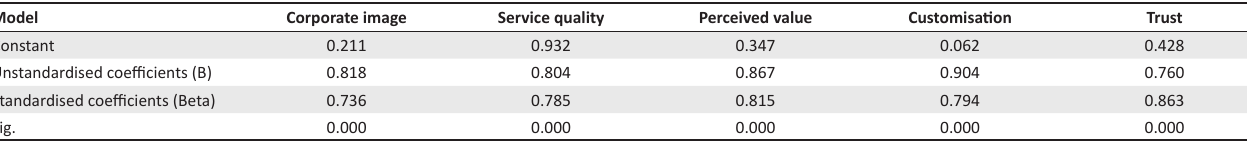
TABLE 4c: Influence of the independent variables on the intervening variable. Coefficients. Model